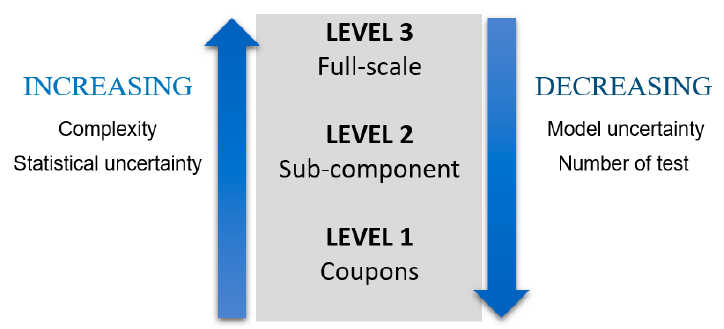
Figure 2. Different test scales